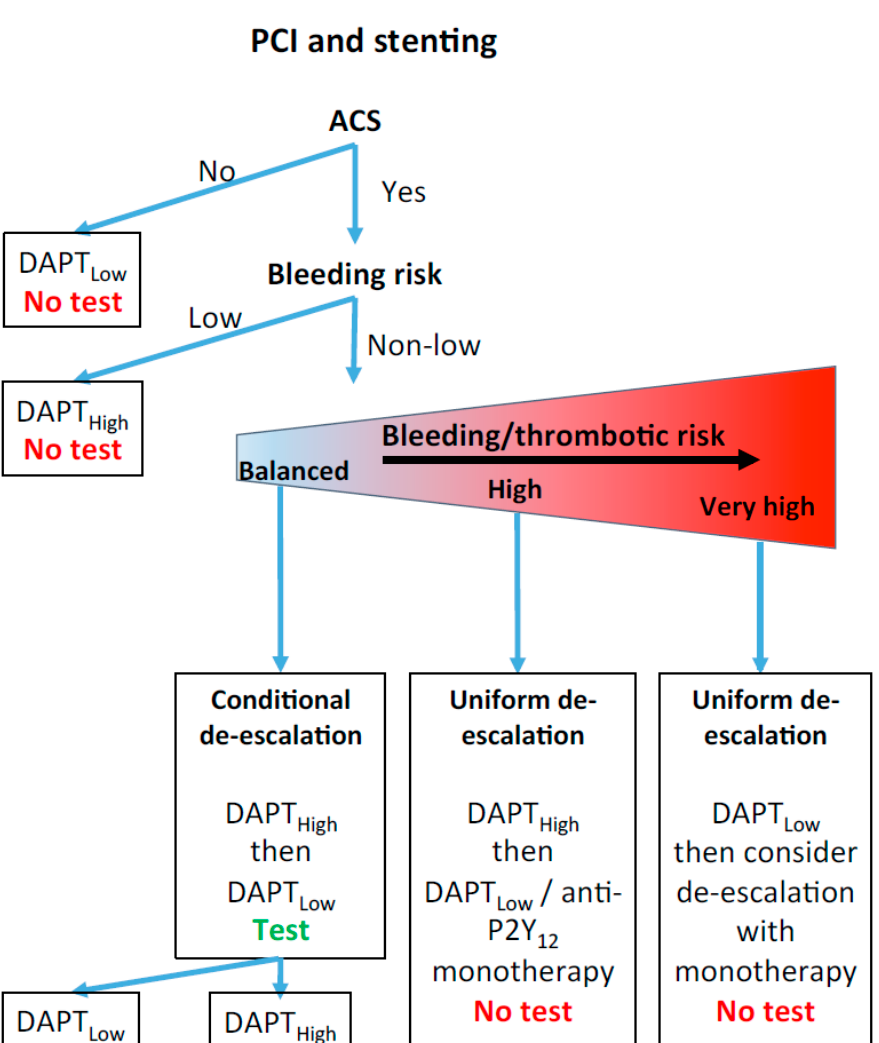
Figure 1. Antiplatelet drug strategy and the role of platelet function tests after a percutaneous coronary intervention. See main text for details. ACS: acute coronary syndrome. DAPT High : dual antiplatelet therapy with aspirin and prasugrel or ticagrelor. DAPT Low : dual antiplatelet therapy with aspirin and clopidogrel. PCI: percutaneous coronary intervention.